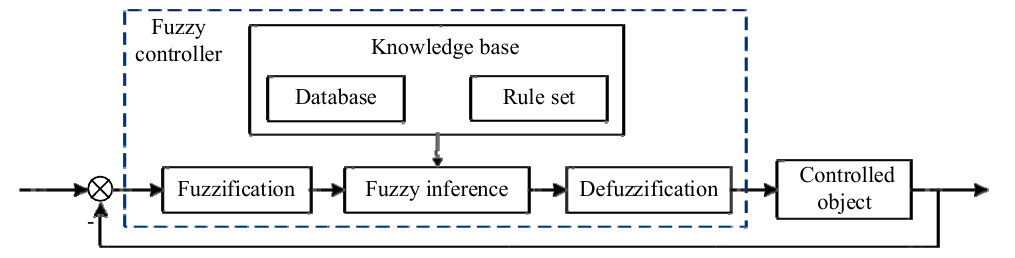
Figure 4. fuzzy controller structure. Figure 4. Fuzzy controller structure.